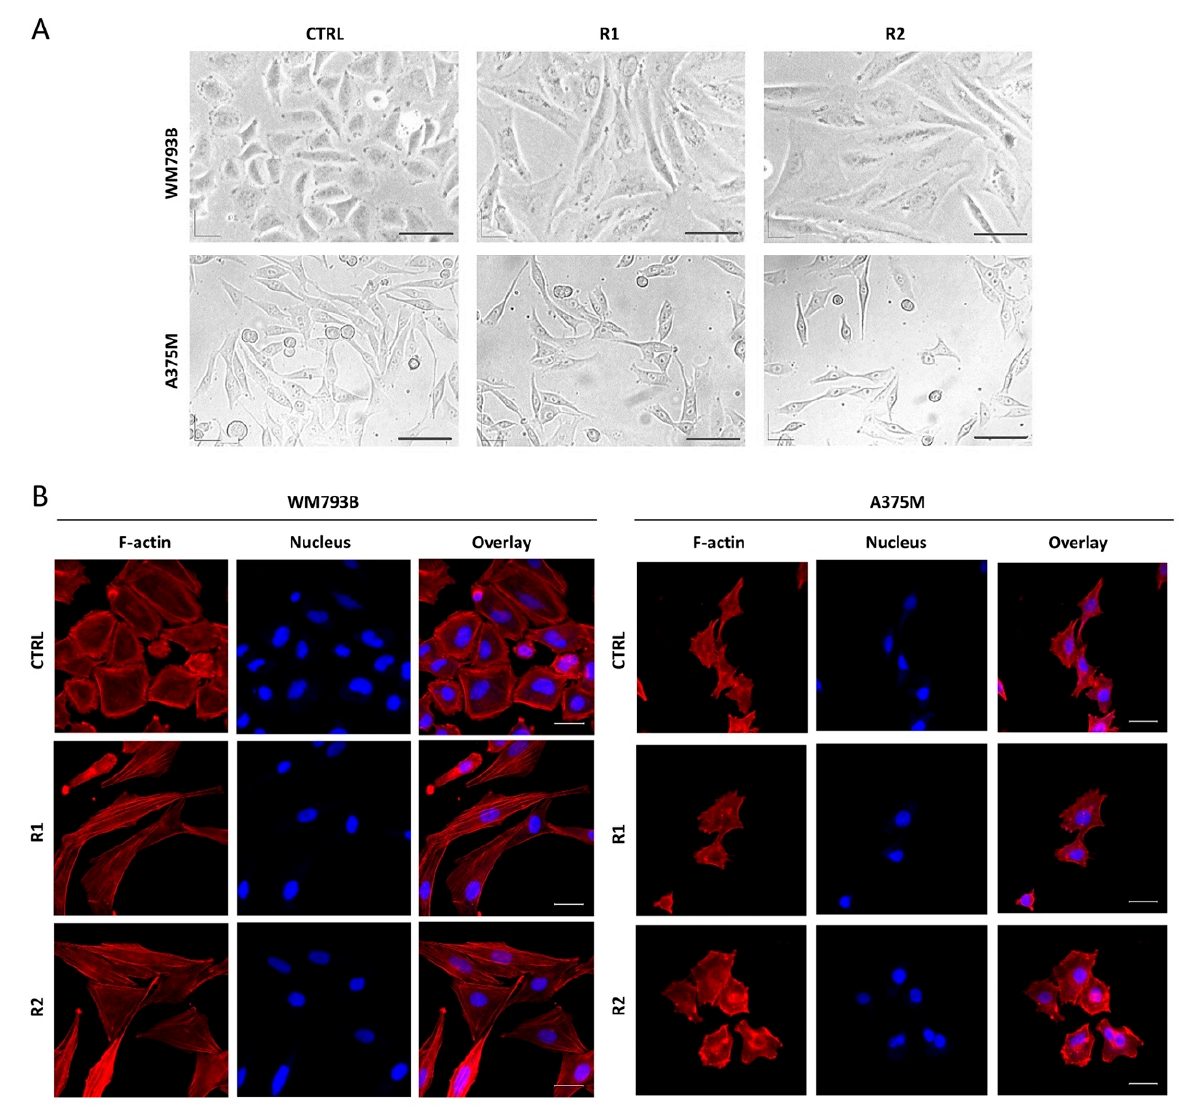
Figure 2. Morphology of primary melanoma cells changed upon vemurafenib treatment. Micrographs show parental (CTRL) and resistant (R) melanoma cells visualized by phase-contrast ( A ) and confocal fluorescent ( B ) microscopy. R1 and R2 represent the cells treated with vemurafenib for 4 and 9 months, respectively. F-actin is visualized with phalloidin-TRITC (red) and DNA with DAPI (blue). The scale bar is set at 150 μ m ( A ) and 30 μ m ( B ).